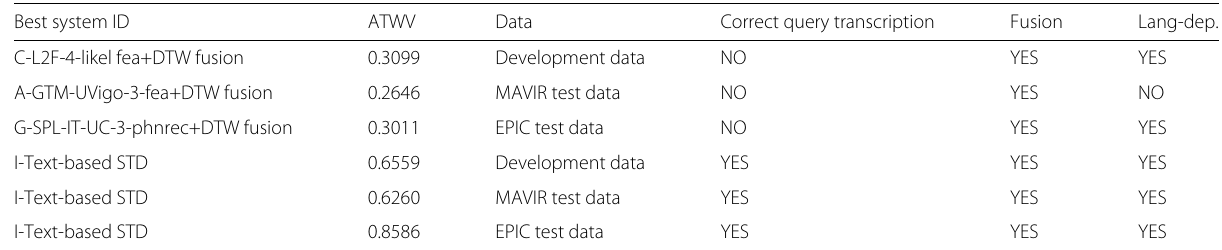
Table 12 Summary of the best QbE STD system results and the I-Text based-STD system of the ALBAYZIN QbE STD 2016 evaluation Best system ID ATWV Data Correct query transcription Fusion Lang-dep.